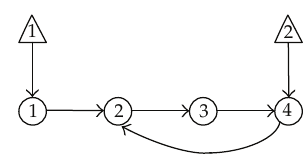
Figure 1: Directed graph G 1 and G 1 .